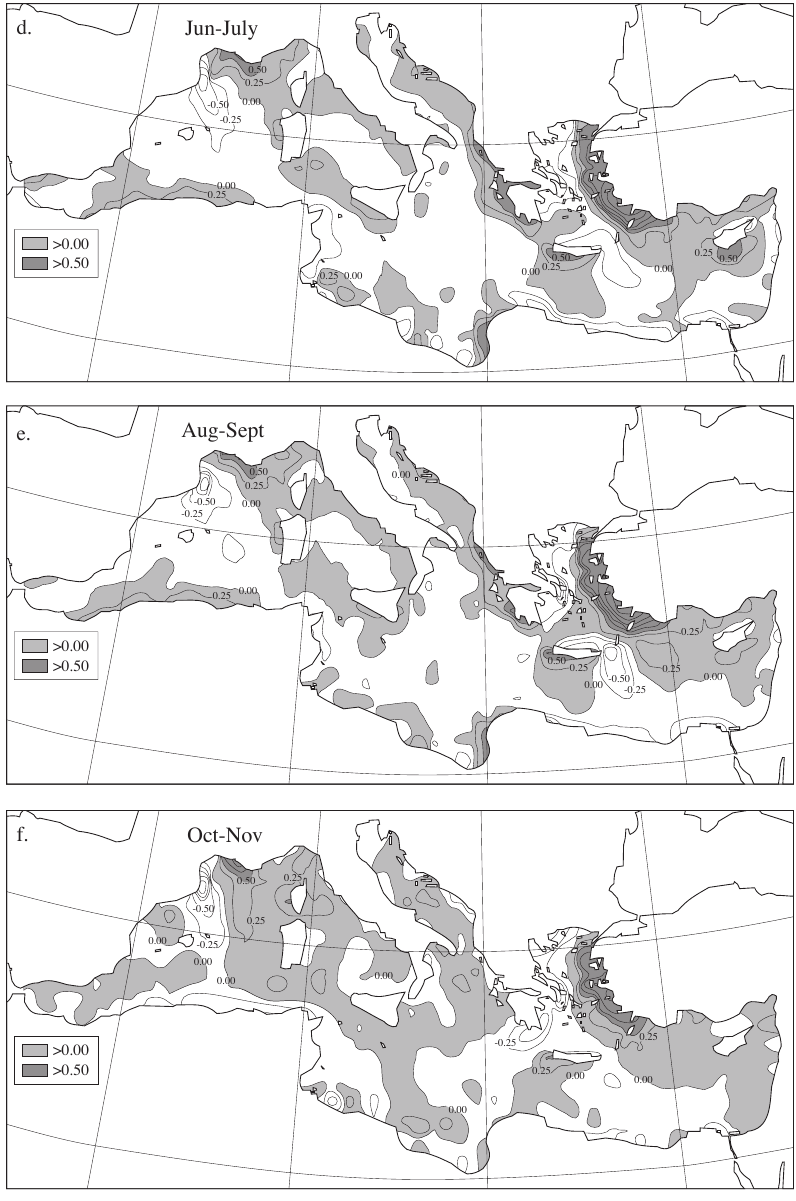
F IG . 4. (Cont.) – Seasonal variation of computed vertical velocities at the bottom of the surface Ekman layer. Units are meters per day. Con- tour interval is 0.25. Shaded areas indicate zones of upwelling. Darker shading indicates upward velocities greater than 0.5 m/day. Unshaded areas indicate zones of downwelling. (a) Dec-Jan. (b) Feb-Mar. (c) Apr-May. (d) Jun-Jul. (e) Aug-Sep. (f)